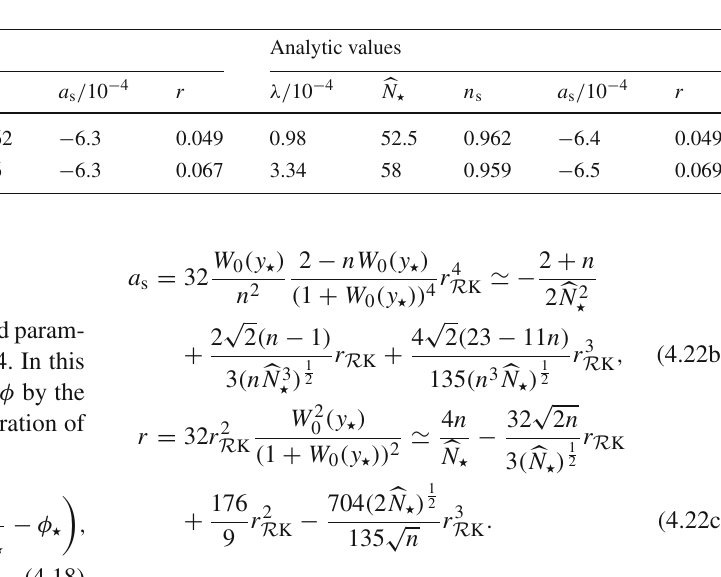
Table 2 Comparison between the numerical and analytic results for p = m = φ (cid:21) = 1 and two different sets of input and output parameters of our model Input parameters Output